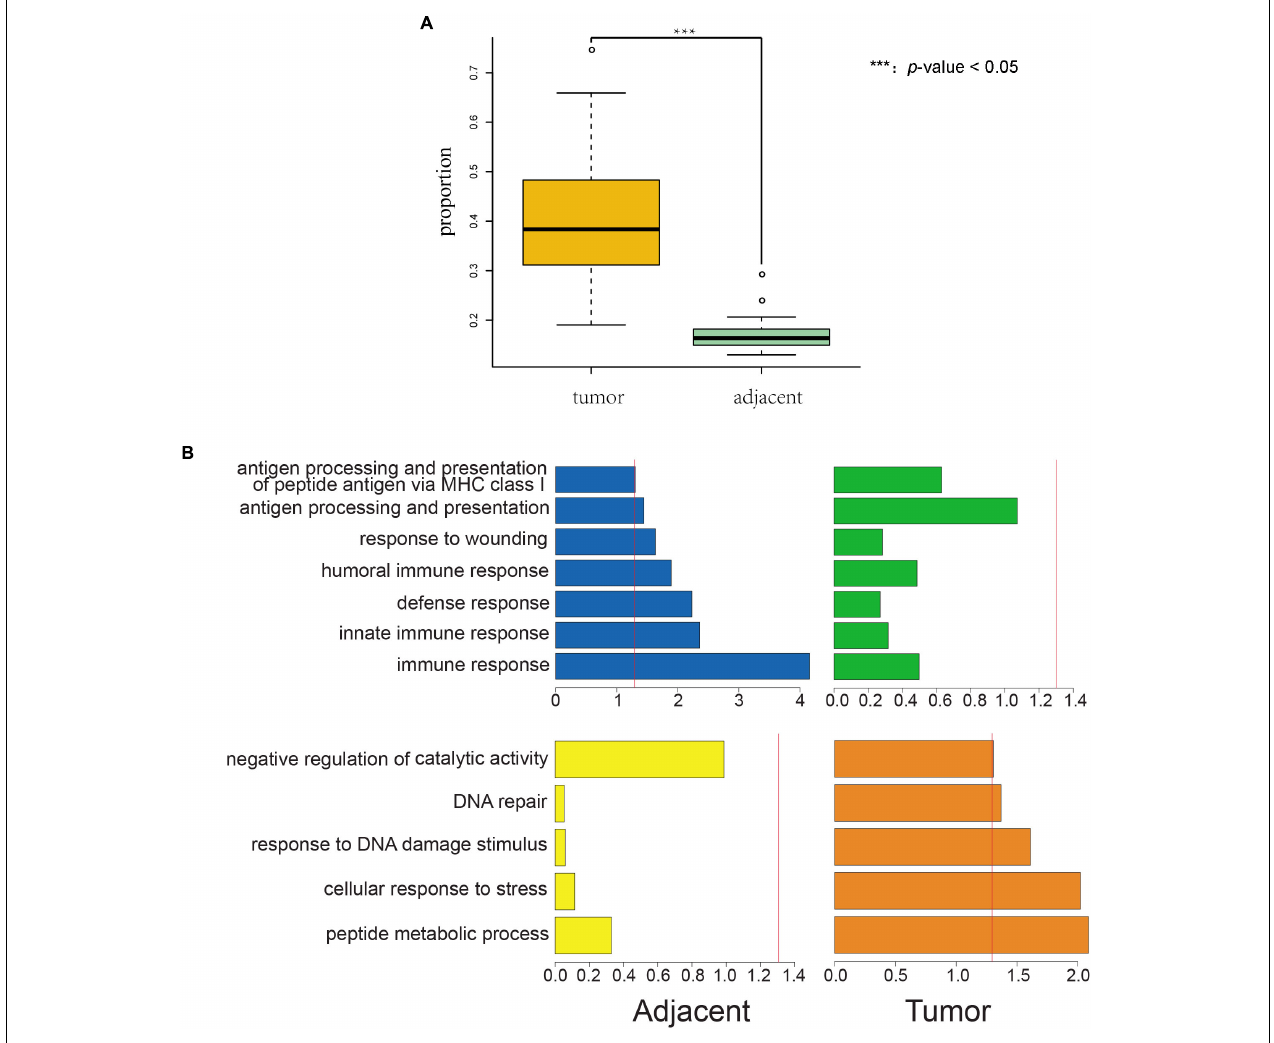
FIGURE 1 | Proportions of AEI in tumor samples are significantly higher than those in adjacent samples, and AEI genes in cancer and adjacent tissues conform to organizational function. (A) A t -test of proportions of AEI in adjacent (green) and cancer (yellow) samples from RNA-seq data shows proportions of AEI in tumors are significantly higher ( p- value = 1.68 × 10 - 37 ) than those in adjacent samples from TCGA data. (B) Gene function cluster analysis for commonly expressed genes that have different frequencies of AEI in tumor and adjacent tissues. The p -value of the clustering term was taken as a negative logarithm. (blue and yellow) Gene function cluster analysis for genes that have high proportions of AEI in adjacent samples and low proportions of AEI in tumor samples. (green and orange) Gene function cluster analysis for genes that have high proportions of AEI in tumor samples and low proportions of AEI in adjacent samples. The red line represents a p- value =